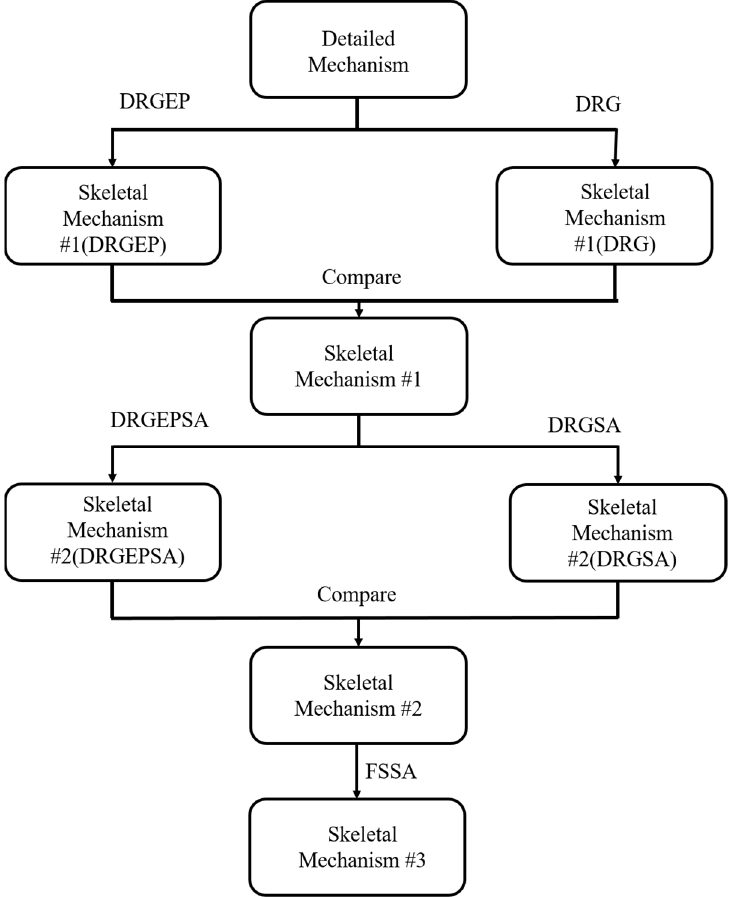
Figure 3. Mechanism reduction process.